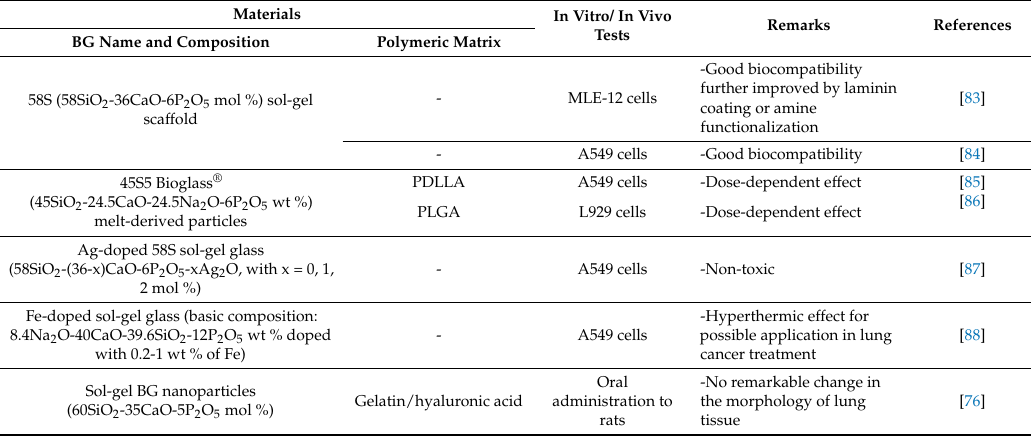
Table 3. Summary of the studies involving the use of BGs for potential application in lung tissue engineering.